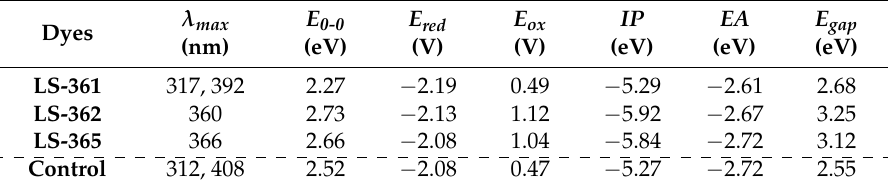
Summary of optical and electrochemical properties of the three dyes and Control for